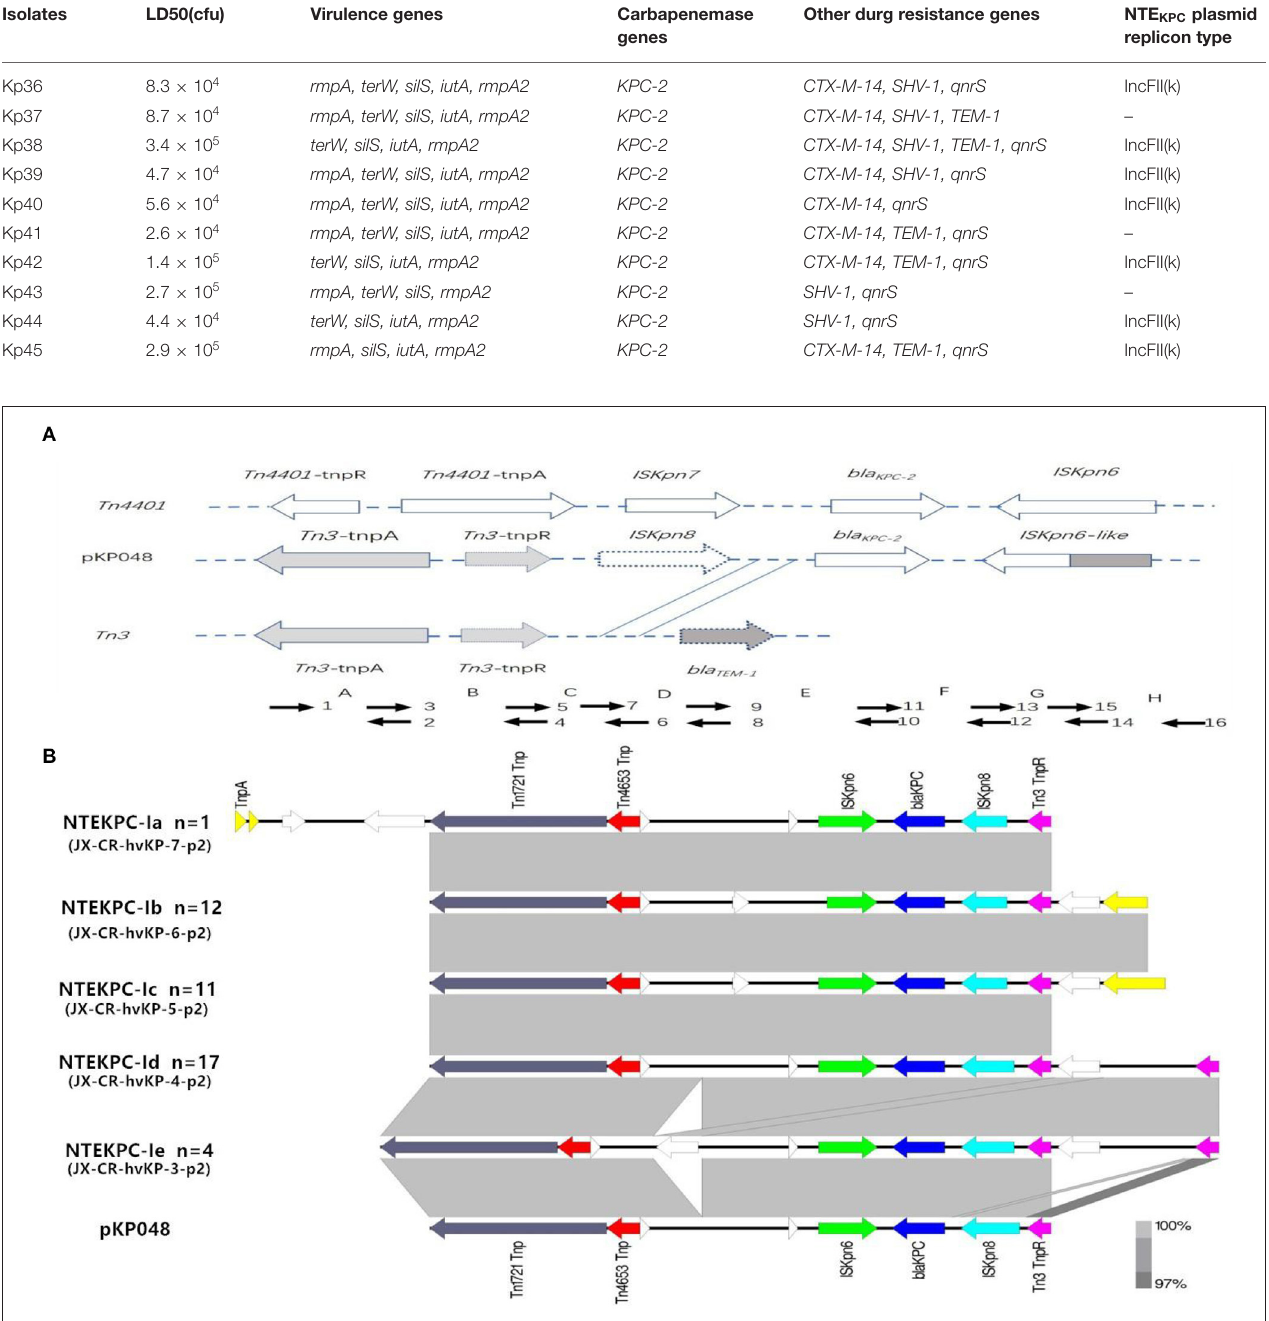
FIGURE 1 | Schematic representation of the genetic structures surrounding the blaKPC-2 gene in the CR-hvKP isolates. (A) Classic Tn3 -based structure in plasmid pKP048; Short arrowheads with numbers were used for PCR mapping. (B) Five distinct NTE patterns. Gene bla KPC − 2 is represented by a blue arrow, and the remaining genes are color coded. NTEKPC-Ib, NTEKPC-Ic, and NTEKPC-Id were the most common genetic structures in the CR-hvKP isolates. between ISKpn8 and bla KPC gene with different sizes (Yang et al., 2013; Li et al., 2016). In this study, the KPC structures of